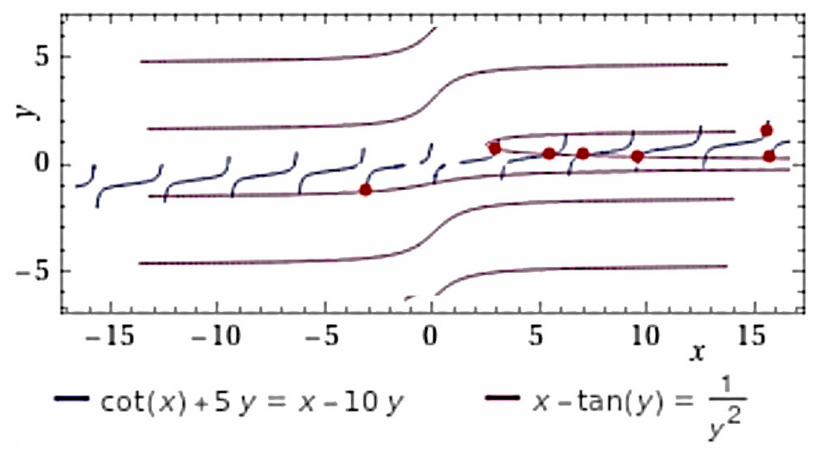
Figure 5. Graphical solution of system (1) with WolframAlpha.